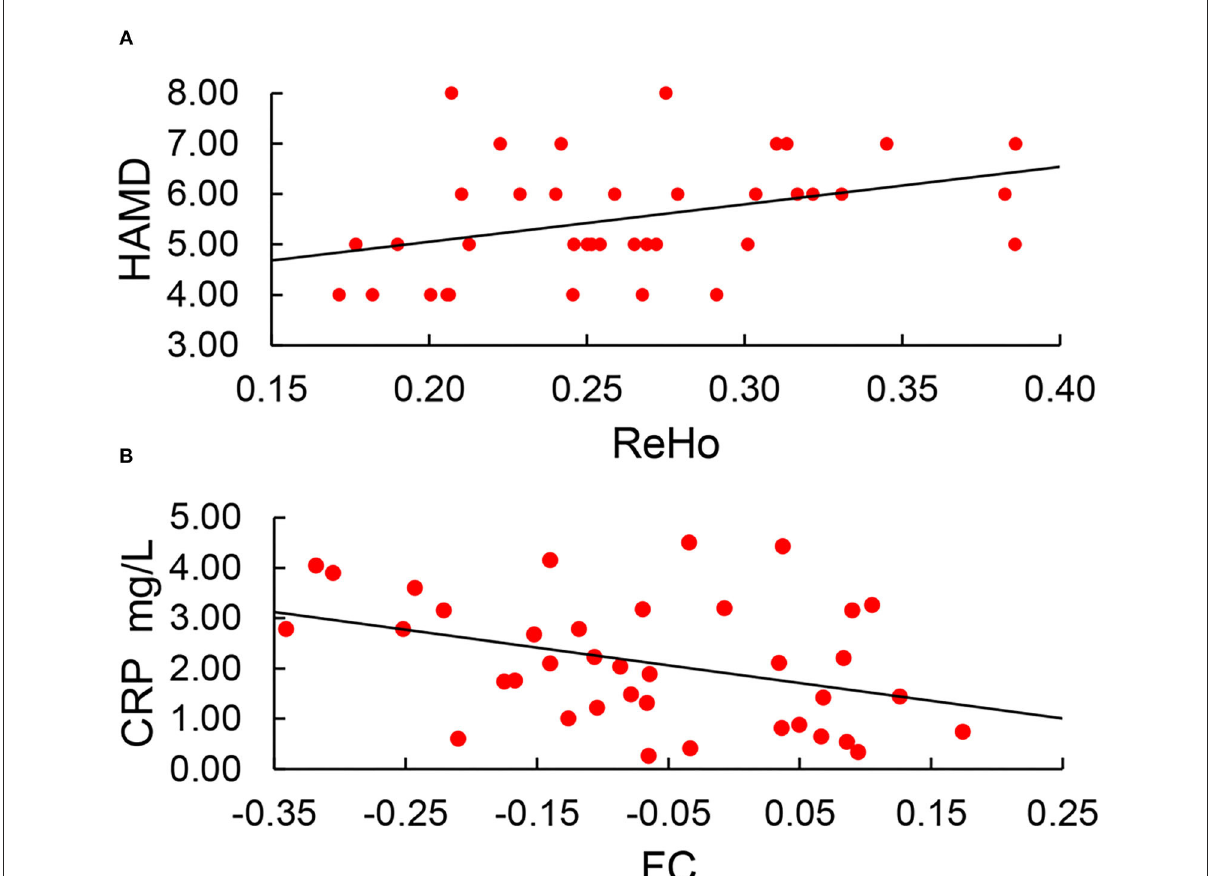
FIGURE4 (A) ReHo was positively correlated with HAMD scores ( r = 0.37, P = 0.022). (B) Setting the region of abnormal ReHo as seed points; only FC between the SOG.L and PreCG.L was negatively correlated with CRP ( r = − 0.268, p =